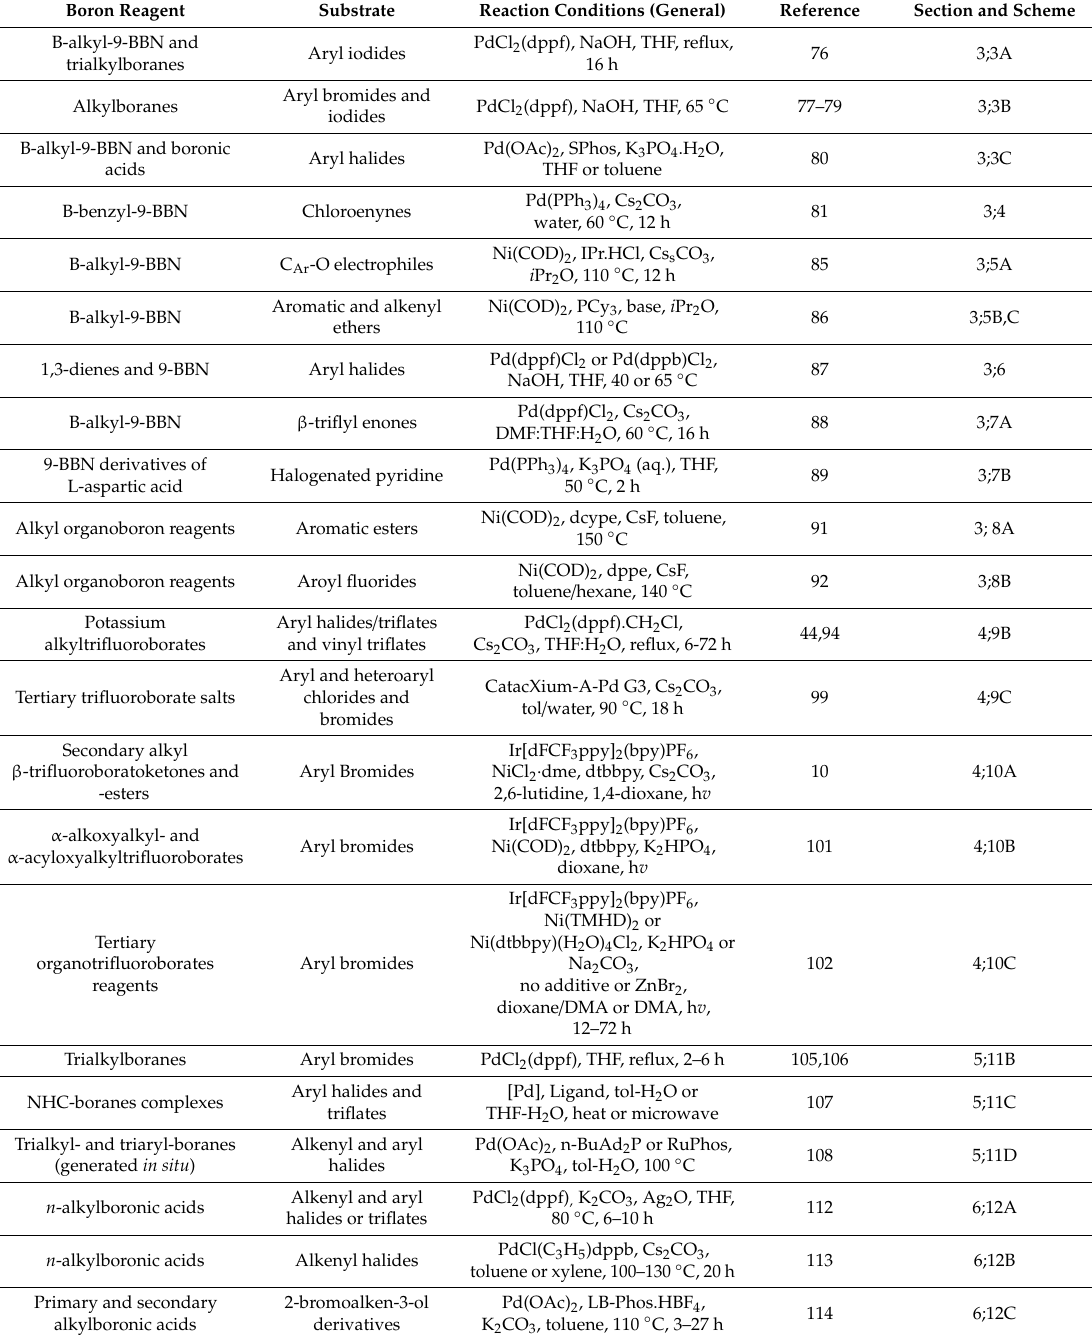
Table 1. General summary of the relevant reports of C(sp 3 )–C(sp 2 ) cross-couplings in this